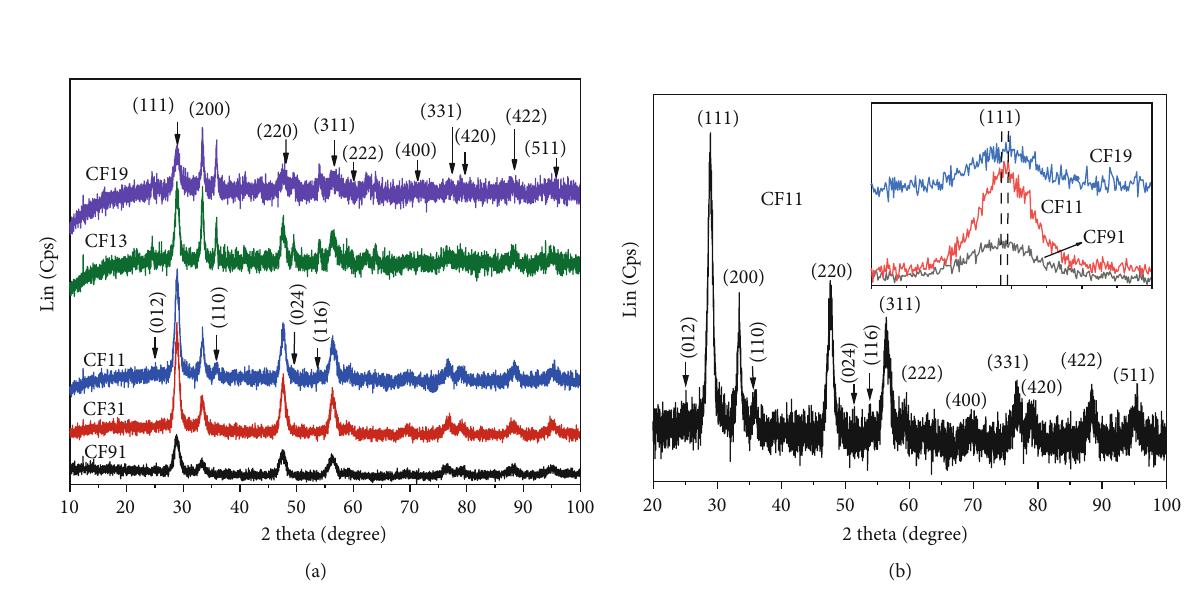
Figure 4: XRD patterns of CeO was redrawn (b).